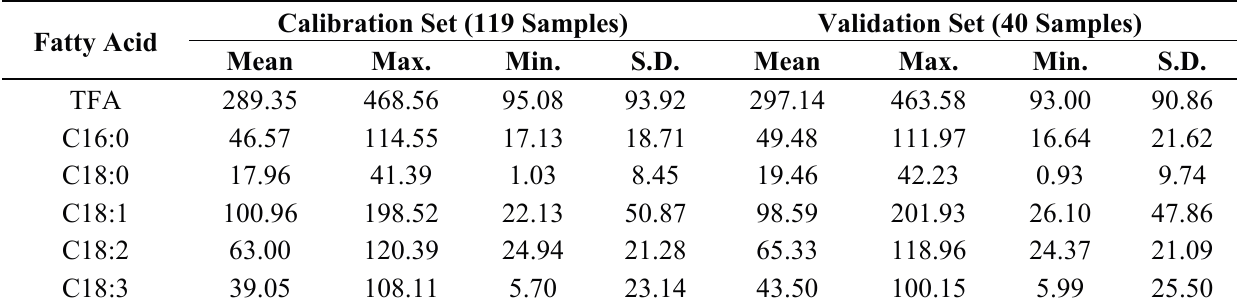
Table 3. Descriptive statistics of the sample sets of C. vulgaris , C. zofingiensis and C. protothecoides used for calibration and validation (contents of various fatty acids expressed as mg/g dry cell